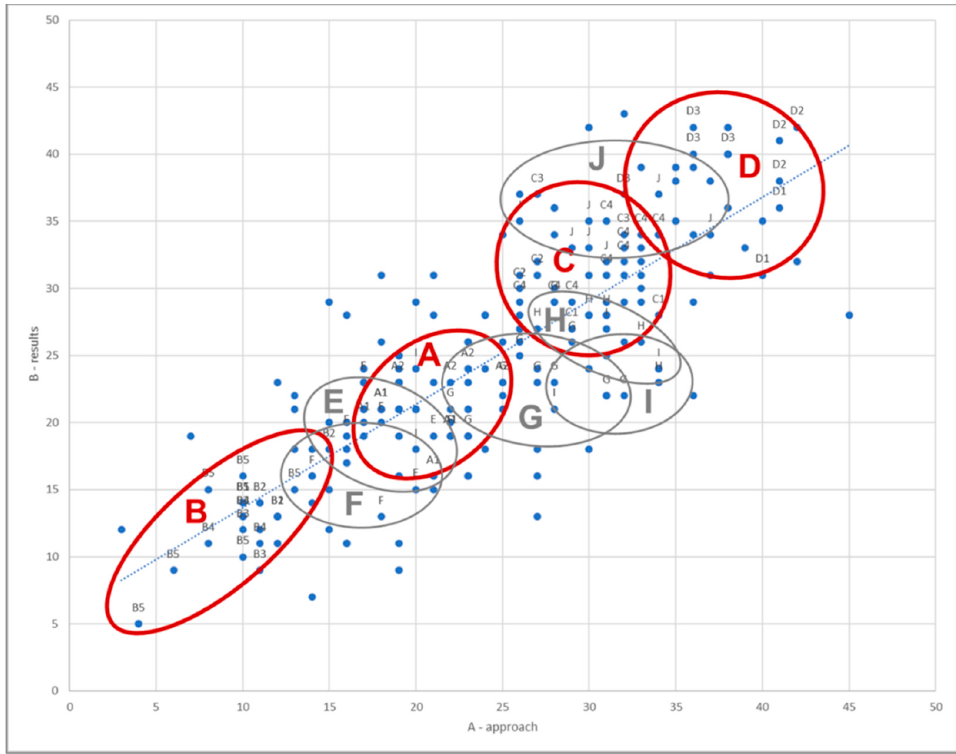
Figure 7. The scatter diagram showing clusters A, B, C, and D; and E, F, G, H, I, and